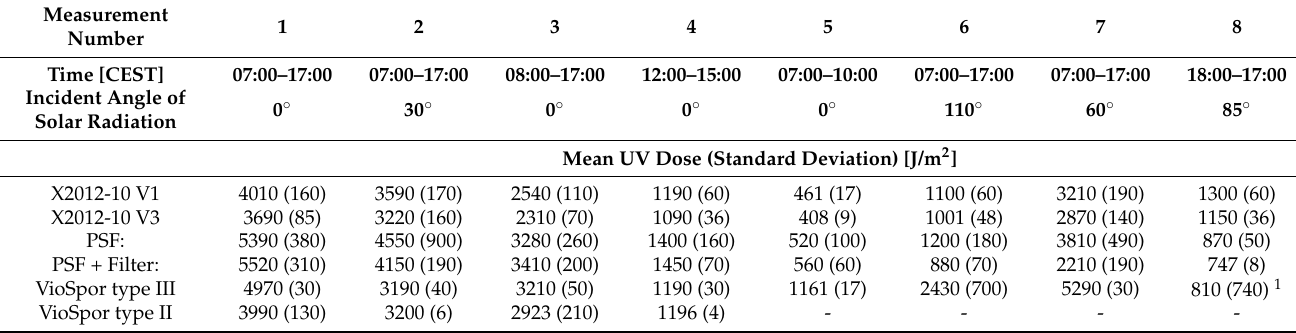
Table 2. Mean UV doses and corresponding standard deviations (in brackets) for each measurement expressed in J/m 2 . Measurement